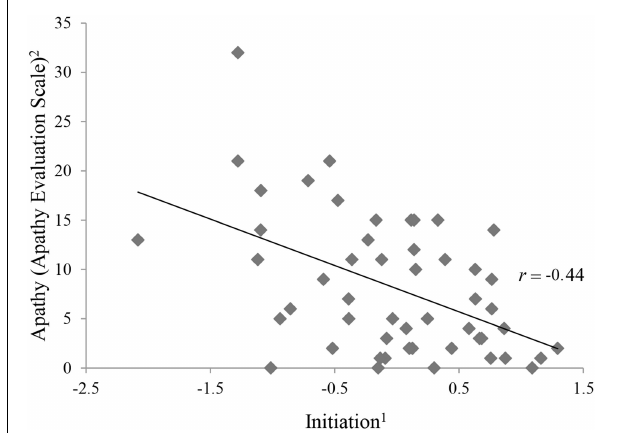
FIGURE 2 | Correlation between apathy and initiation. 1 The ability to start an intentional actions self-motivated. 2 Apathy Evaluation Score represents raw